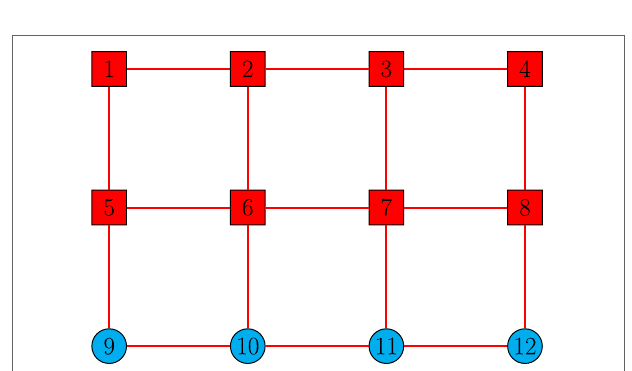
FIGURE 5 | Communication graph of the sensor network in Examples 2 and 3 with 8 active nodes and 4 passive nodes (lines denote communication links, squares denote active nodes, and circles denote passive nodes) Tran et al.